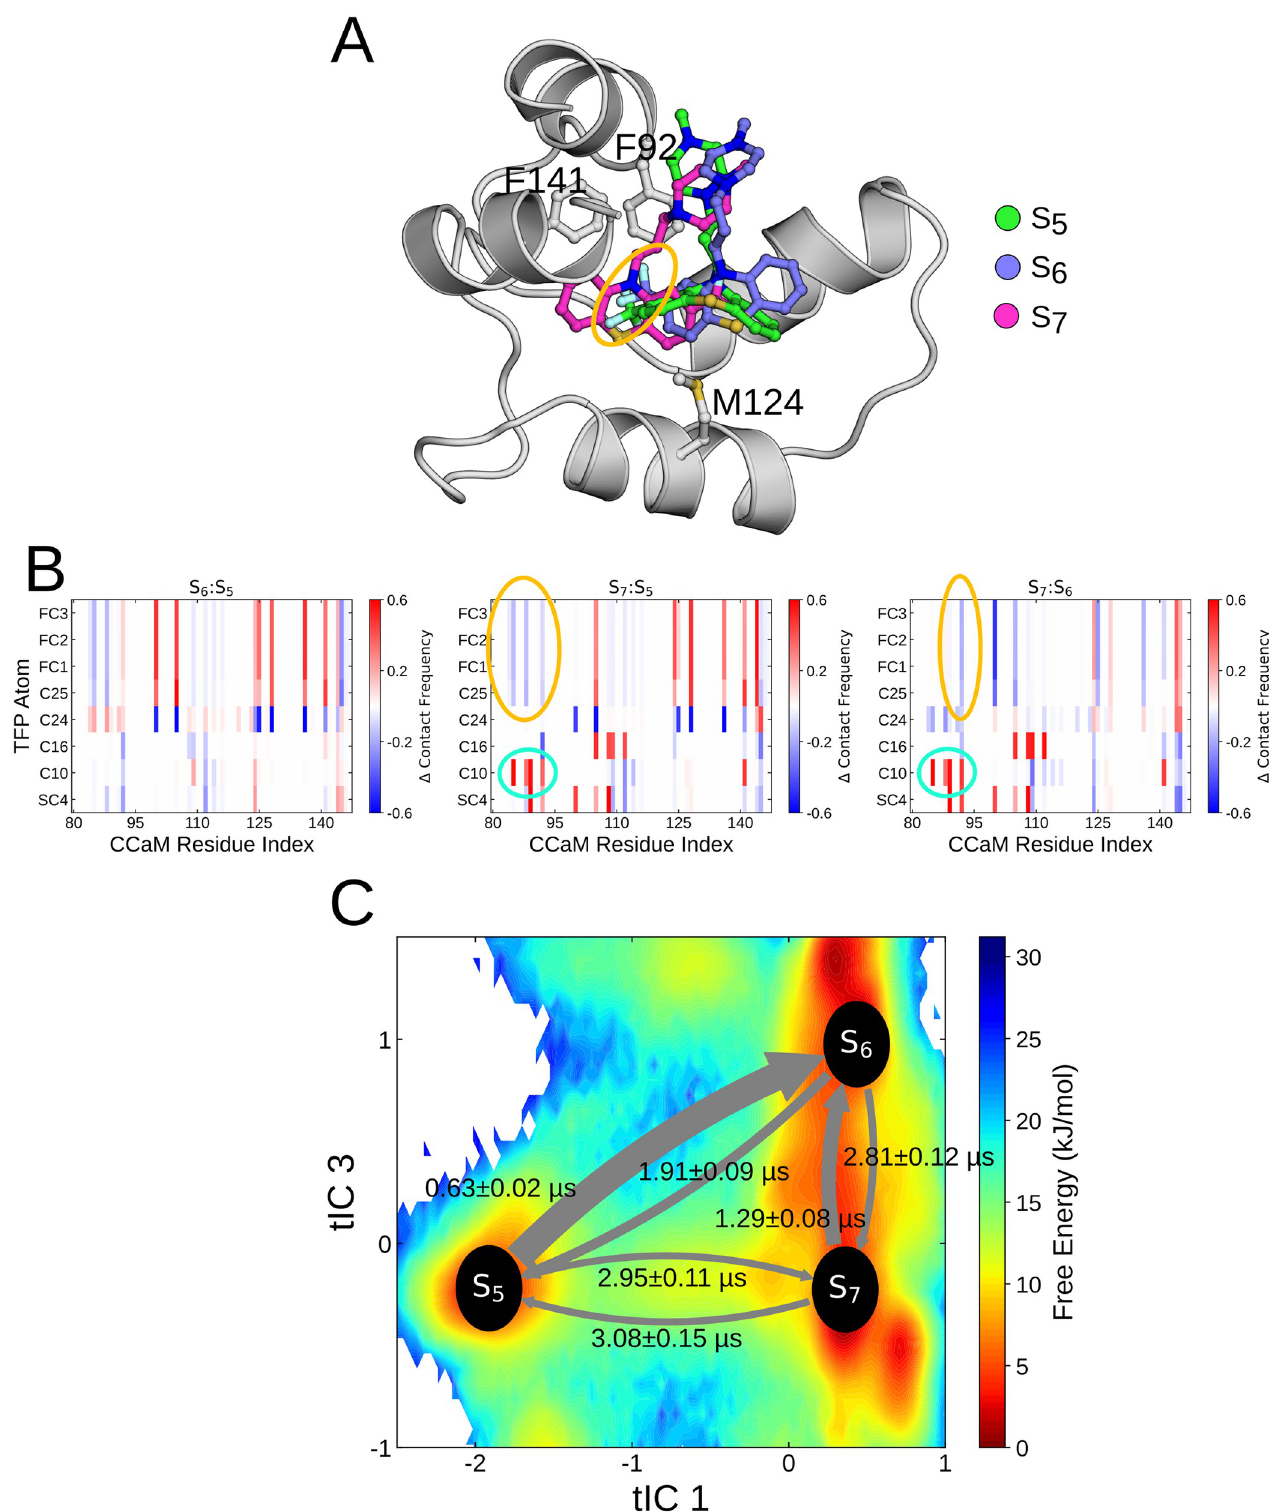
Fig 3. (A) Representative structures of the S 5 , S 6 and S 7 macrostates aligned using the C α C-CaM. The flipped orientation that buries the CF 3 moiety within the S 5 and S 6 macrostates is highlighted using an orange circle. The three F92, F141 and M124 residues whose interactions characterize apo- and holo- CaM states are illustrated. (B) Relative contact frequency of the TFP atoms with C-CaM residues compared between the three S 5 , S 6 and S 7 macrostates. The flipped